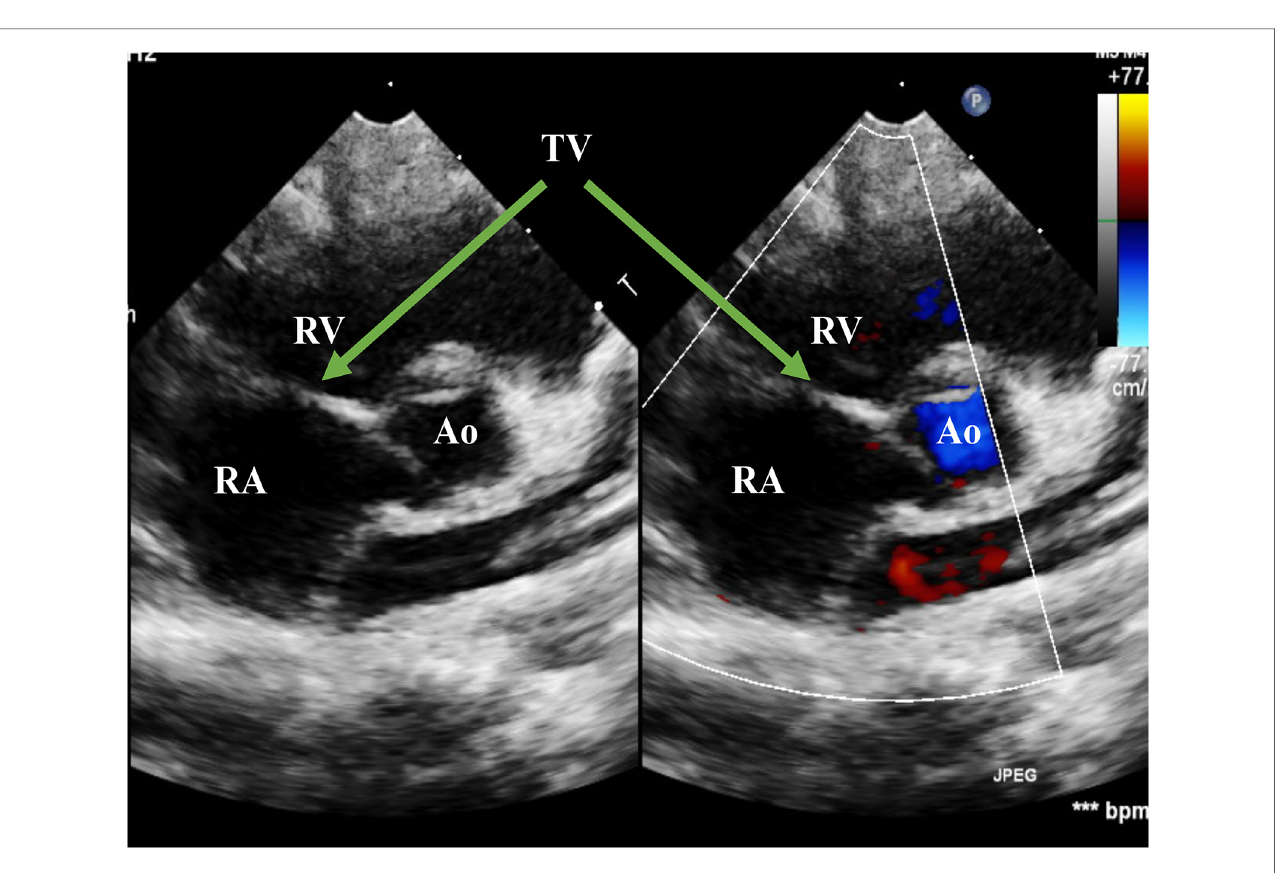
FIGURE 5 Echo at the latest visit in the PSAX view. The fi gure showed good coaptation of the TV in the systolic phase. PSAX, parasternal short-axis view; RA, right atrium; RV, right ventricle; Ao, Aorta; TV, tricuspid